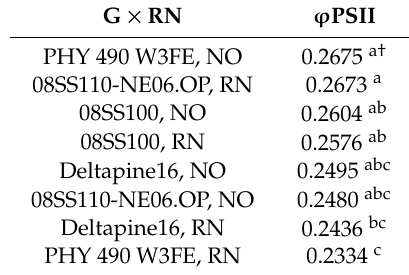
Table 6. Interaction effect of genotype (G) and reniform nematode (RN) treatments on the efficiency of photosystem II ( φ PSII ) of cotton genotypes at 30 days after planting. G ×